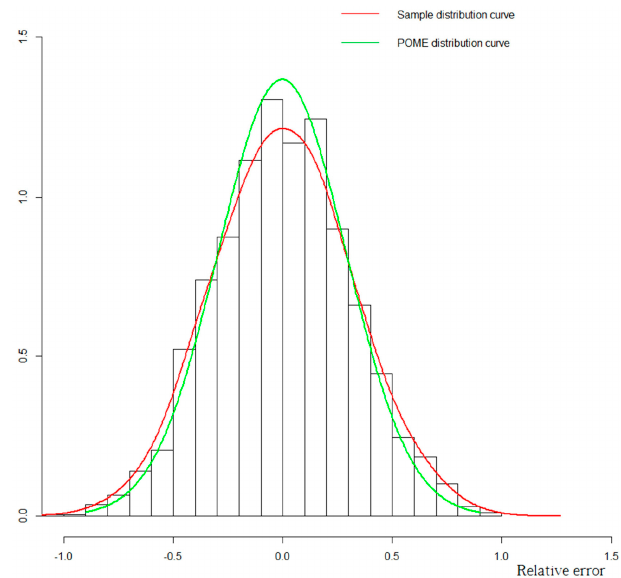
Figure 4. Comparison of the principle of maximum entropy (POME) distribution curve and the sample distribution curve.